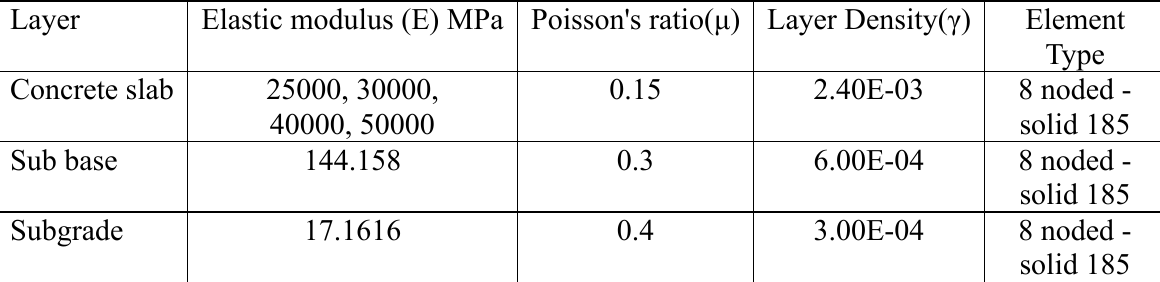
Mechanical Characteristics Input Parameters of layer forming in Rigid